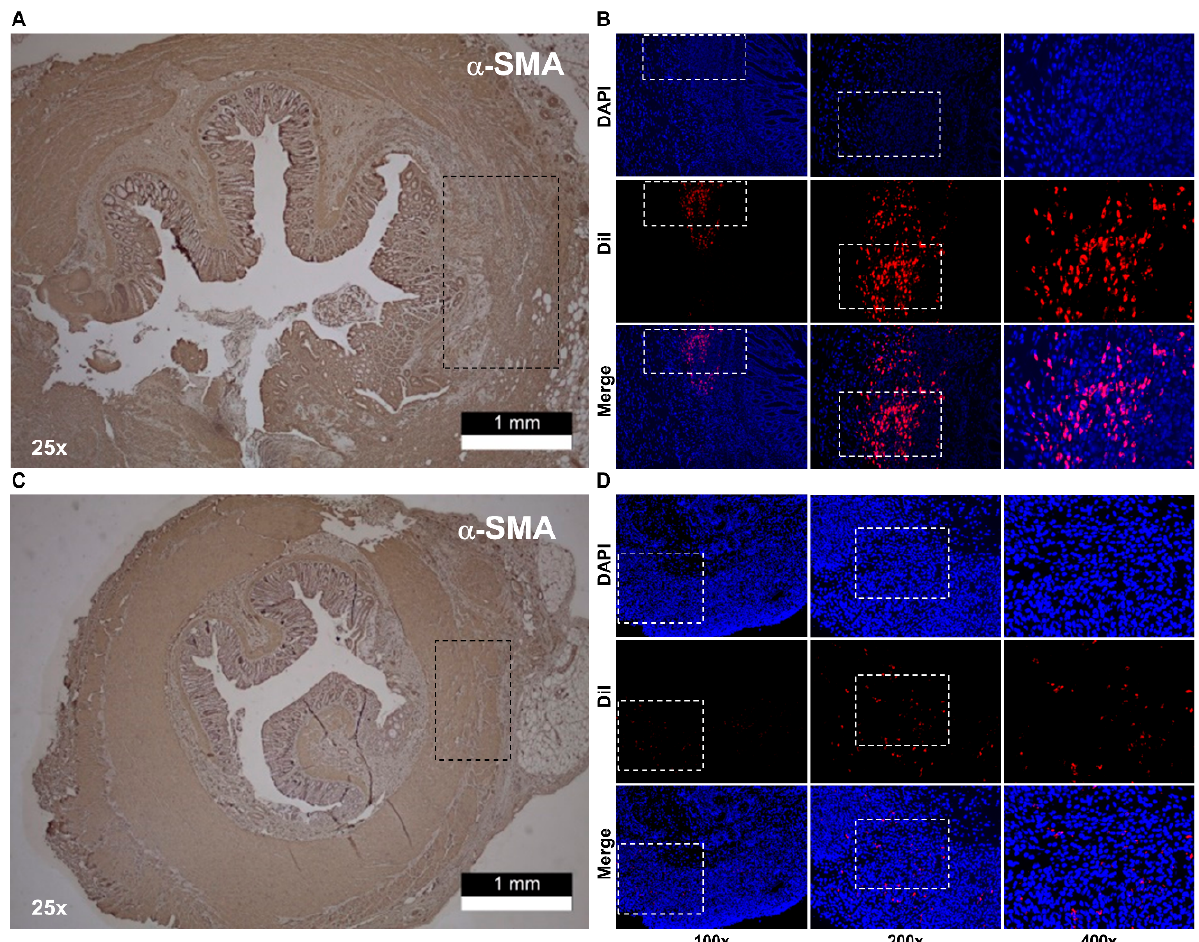
Figure 5. Cell tracking for Dil-labeled hADScs. Histologic examination with fluorescent dye for impaired smooth muscle layer (dotted line box): ( A ) Muscular destruction of α -SMA stained layers in the IAS ring compared to ovoid and longitudinal smooth muscle bundles at non-injury sites, and ( B ) Dil tracking of labeled hADScs with fluorescent dye (dotted line box) one week after treatment. ( C ) Restoration of smooth muscle layer (dotted line box): proliferation of α -SMA stained muscle fibers without infiltration of fibrotic tissue, and ( D ) tracking of labeled hADScs two weeks after treatment (dotted line box). hADSc, human adipose-derived stem cell; α -SMA, α -smooth muscle actin; IAS, internal anal sphincter.